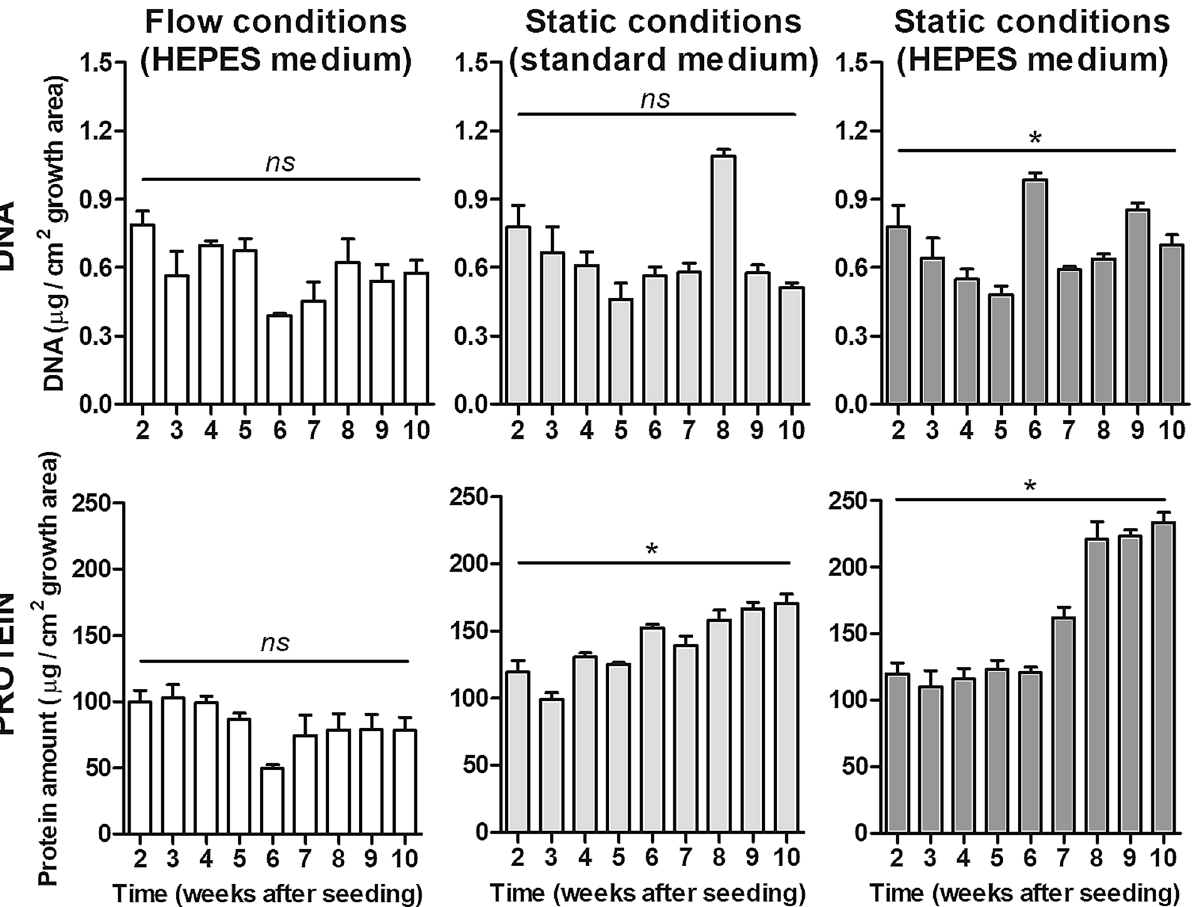
Figure 2. HepaRG cell density as measured as the amount of DNA ( A ) and protein ( B ) per cm 2 growth area in the OOC-devices (flow conditions; white bars) and in 96-well plates (static conditions; standard medium (light grey bars) and with HEPES medium (dark grey bars)). Differences between weeks within one condition were analyzed with a Kruskal–Wallis test. ns not significant, * P <